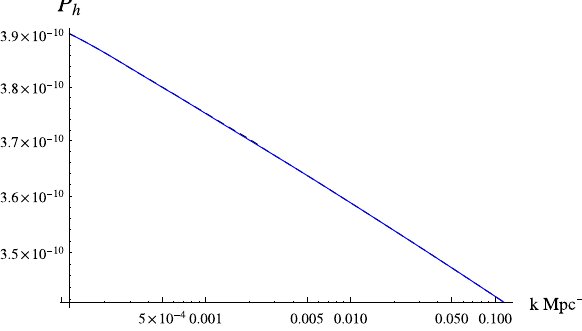
Fig. 7 The numerically computed spectrum of the primordial curva- ture fluctuations P ζ and of the tensor perturbations P h are plotted for the best-fit values in Table 1: λ = − 1 . 12 × 10 − 12 ,σ = 0 . 053, and